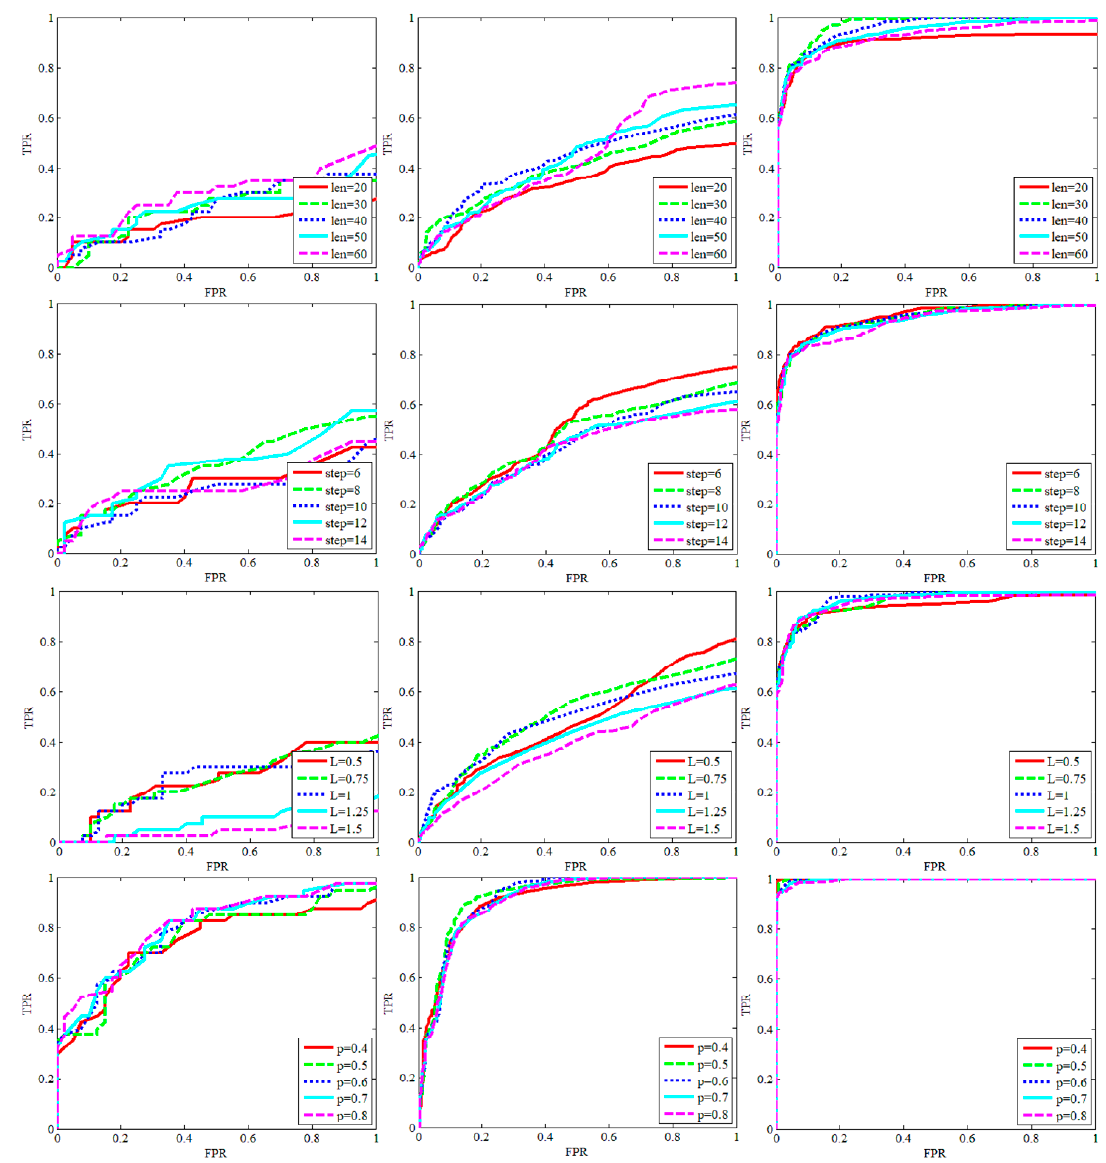
Figure 11. Parameter setting comparison.